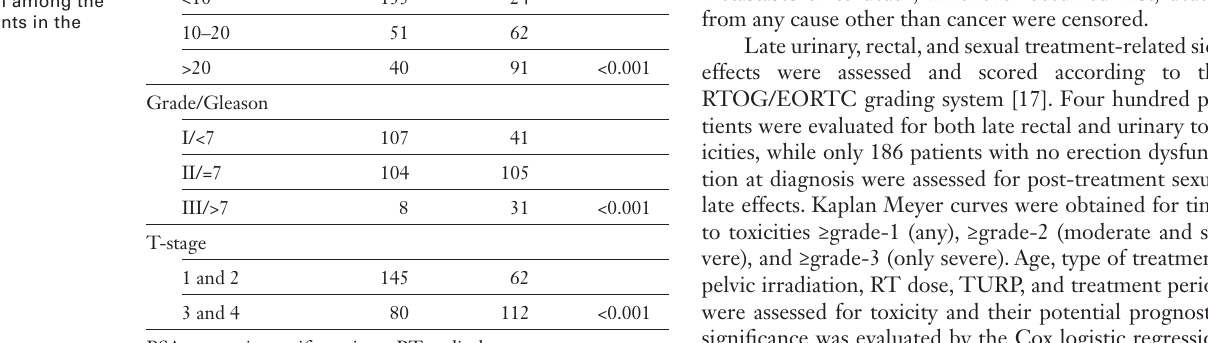
Disease-related char- acteristics and treat- ment arm among the 408 patients in the